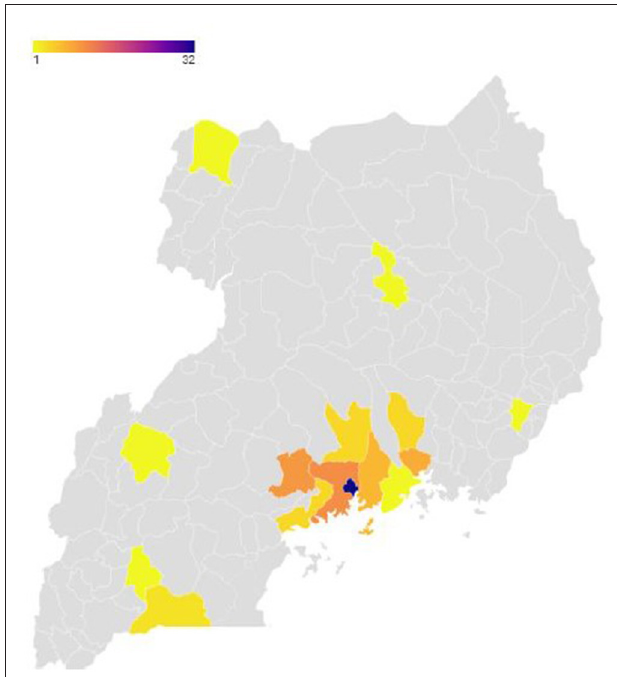
FIGURE 2 | Map of Uganda showing districts where the studies were conducted.